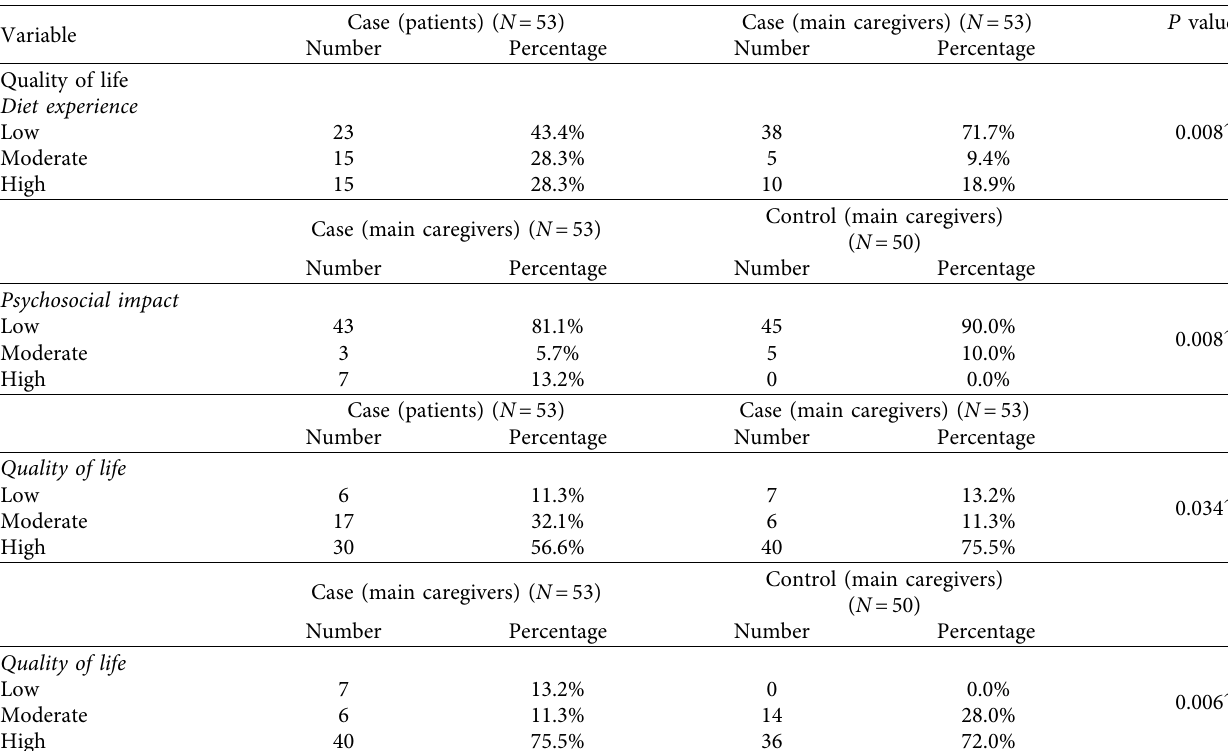
Table 4: Quality of